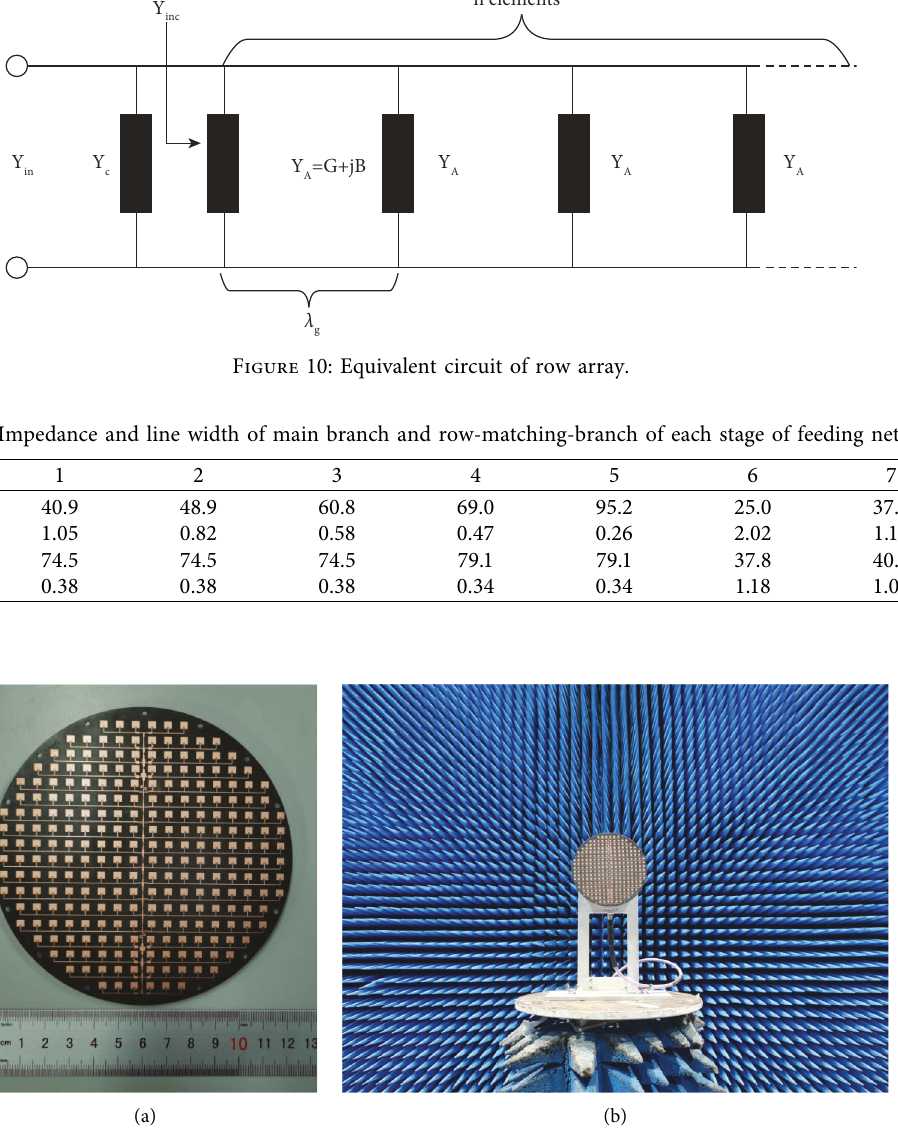
Figure 11: Element arrangement of the row array. (a) Photograph of the fabricated antenna. (b) Photograph of the antenna tested in the anechoic